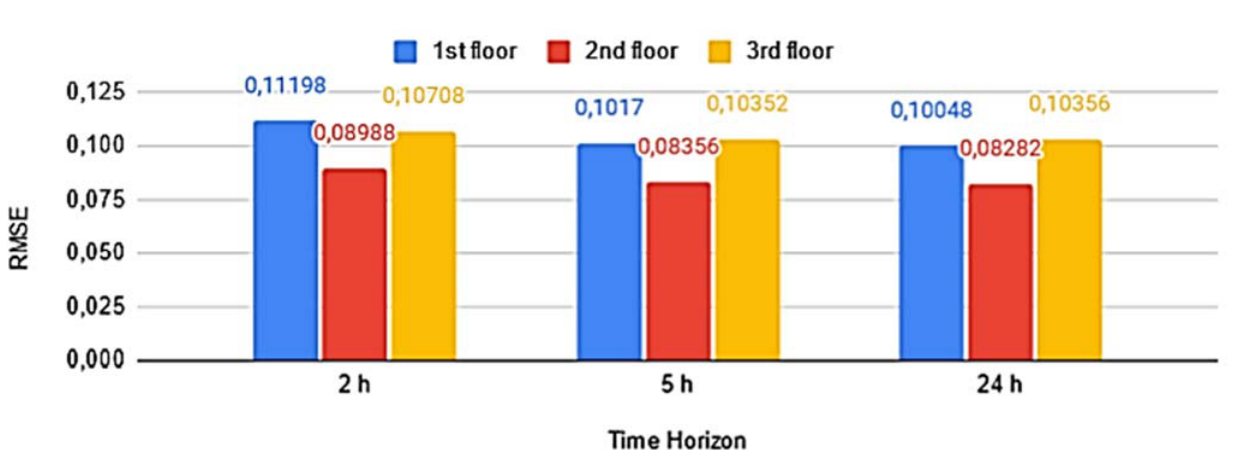
Figure 15. Average RMSE concerning approach calculated for the validation set on 2 h prediction horizon. The single-office predicted temperatures using chosen models for each time horizon are summarised in the table below (Table 4).